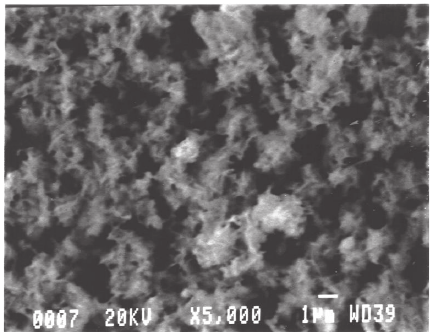
Figure 5: SEM of a CeO 2 /5% MMT nanocomposite film.